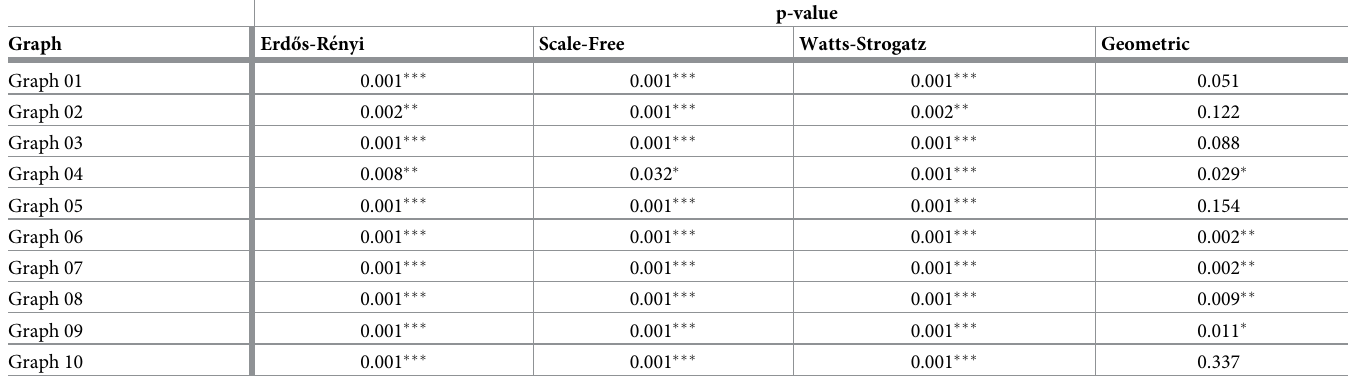
Table 2. Estimated p-values. Each empirical graph is associated with an estimated p -value ð ^ p Þ of being an outcome of an Erd ő s-Re´nyi, Fitness scale-free model, a Watts- Strogatz small word or a Geometric model. As in Table 1, empirical graphs are sorted according to their